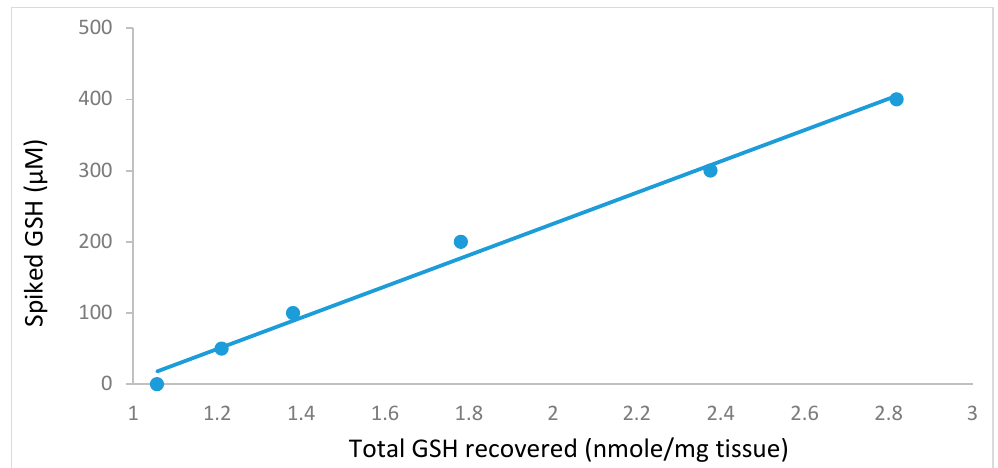
Figure 9. Overlaid chromatograms of the GSH standards at a wavelength of 450 nm.